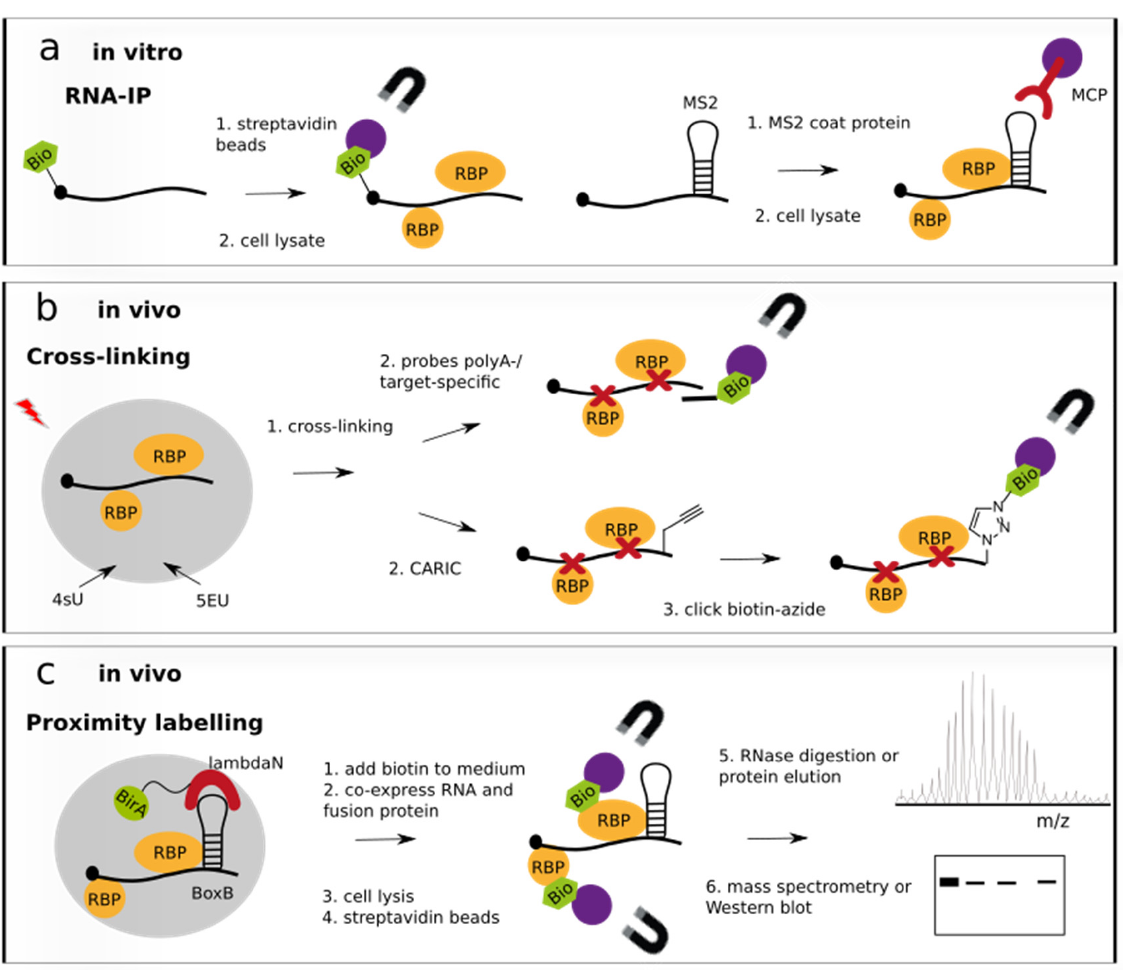
Figure 1. RNA-centric approaches to study RNA–protein interactions. ( a ) In vitro-transcribed RNA tagged with biotin, aptamer or stem-loop MS2 is incubated with cell lysate or purified protein and pulled down with streptavidin beads or MS2-coat protein immobilized on beads for analysis of bound proteins. Protein analysis is performed by Western blot or mass spectrometry similar to steps 5. and 6. shown in ( c ). ( b ) UV-cross-linked RNA-protein complexes are recovered by IP with target-specific probes or poly(dT) oligonucleotides coupled to beads (upper case). In the click-chemistry-based method CARIC, metabolically labelled 5-ethinyluridine (5EU)-transcripts are clicked to biotin-azide for purification (lower case). Metabolic labelling with 4-thiouridine (4sU) serves to enhance cross- linking efficiency. Although not shown, recovered RNA-protein complexes are subjected to similar analysis steps 5. and 6. as shown in ( c ). ( c ) Proximity labelling is performed by recruiting a biotin ligase BirA in close vicinity to an RNA targeted by the fusion protein. A BoxB or MS2 stem-loop is recognised and bound by the λ N peptide or MS2 coat protein, respectively. Subsequent IP of the biotinylated RBPs in complex with the RNA and elution of the RBPs allows for protein analysis by mass spectrometry or Western